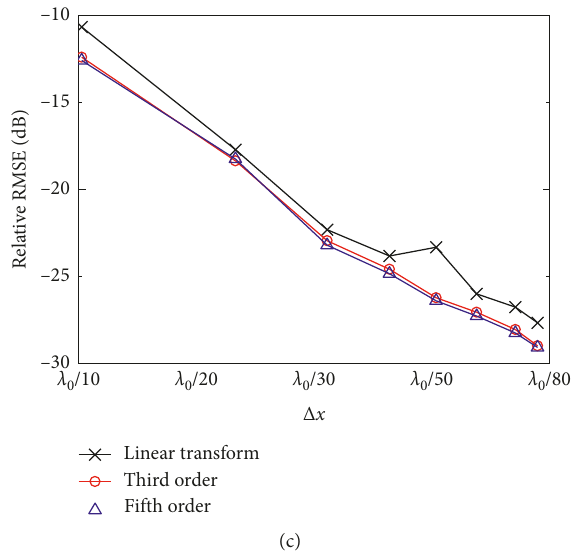
Figure 11: Relative root mean square error: (a) the cloak, (b) the rotator, and (c) the concentrator. The fifth-order function had the smallest error followed by the third-order and linear